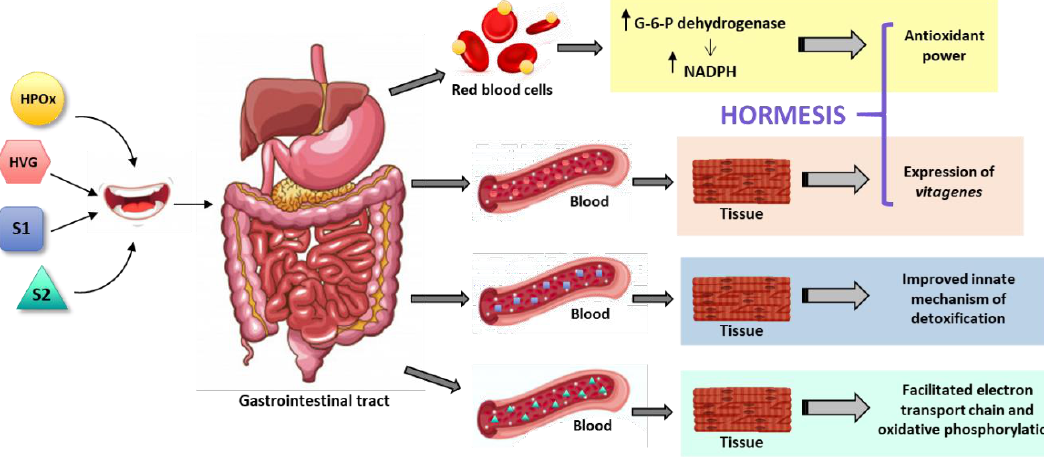
Figure 2. Scheme of indirect antioxidant mechanisms including hormetic actions exerted by pro-oxidants or vitagene expression regulators, and the use of supplements that improves innate mechanisms of detoxification or facilitates mitochondrial function. HPOX—hormetic pro-oxidant, HVG—vitagene-enhancing hormetic compound, S1—supplement type 1, S2—supplement type 2.